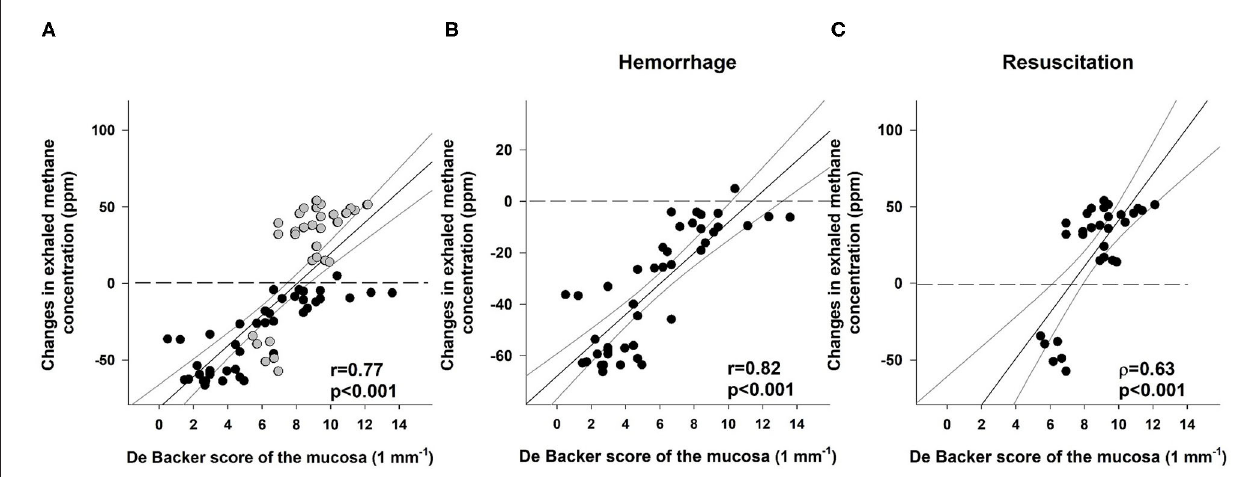
FIGURE 6 | Correlation between the De Backer score (1 mm − 1 ) for the mucosa and changes in exhaled methane concentration (ppm) during the whole course of experiments ( A ; black scatters show the data collected during bleeding, and gray scatters show the data recorded during resuscitation), the hemorrhage ( B ; black scatters) and resuscitation phases ( C ; black scatters). The plot demonstrates the regression line (black line) and corresponding r and ρ values as indicators of the strength of the linear correlation and p significance values.